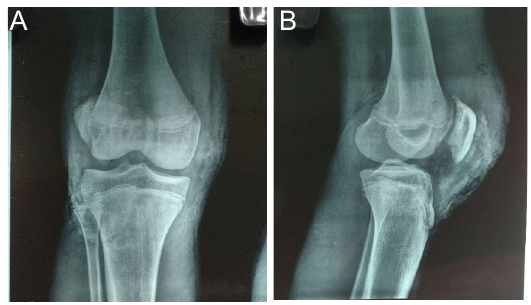
Figure 1. (A) X-ray AP view of knee joint showing lateral femoral condyle patella. (B) X-ray lateral view of knee joint showing fracture.